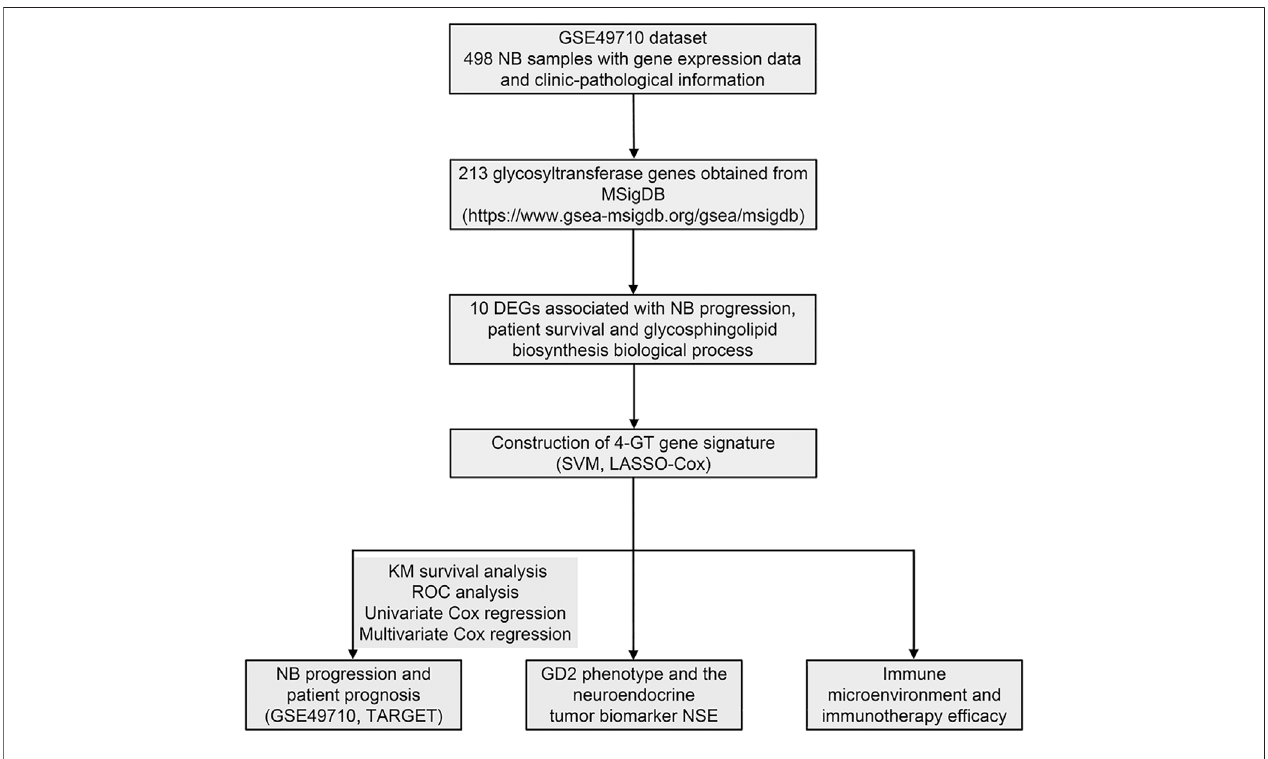
FIGURE 1 | Flowchart of this